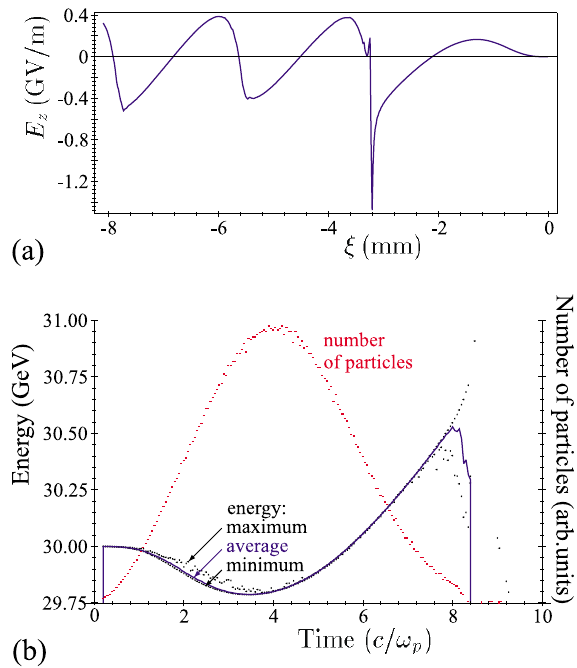
FIG. 4. (Color) (a) Longitudinal electric field, (b) energy and number of beam particles after 1.4 m plasma for the low- resolution simulation of the E-157